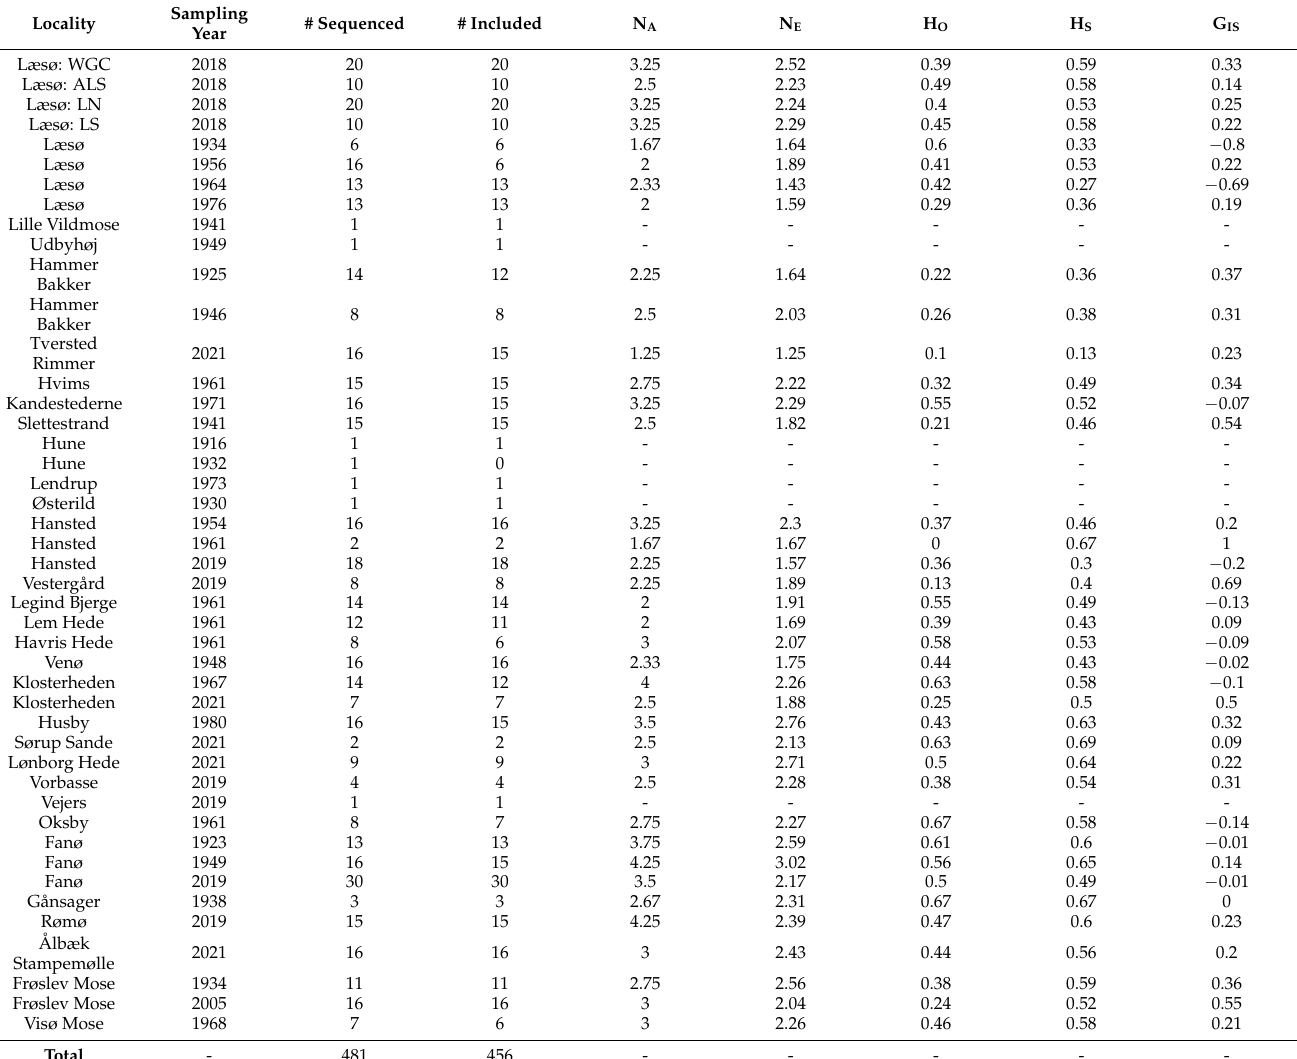
Table 2. Summary of samples, genetic diversity (N A = number of alleles, N E = effective number of alleles, H O = observed heterozygosity, H S = expected heterozygosity), and estimated inbreeding (G IS ) for the combined